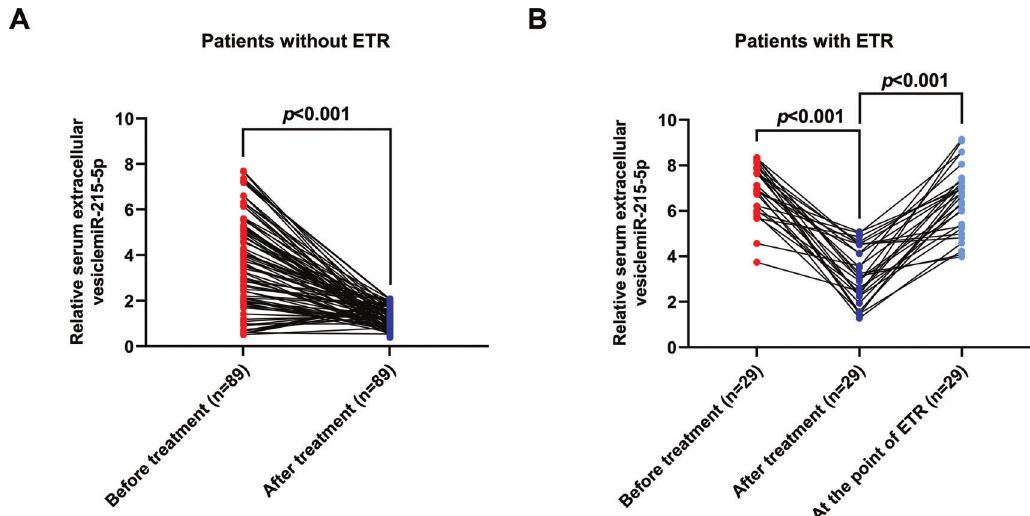
Figure 3 - The serum EV-miR-215-5p level was sensitive to treatments. (A) Serum EV-miR-215-5p level was significantly decreased in GC patients without ETR after gastrectomy. (B) The serum EV-miR-215-5p level was decreased in GC patients with ETR after gastrectomy but increased at the point of ETR.